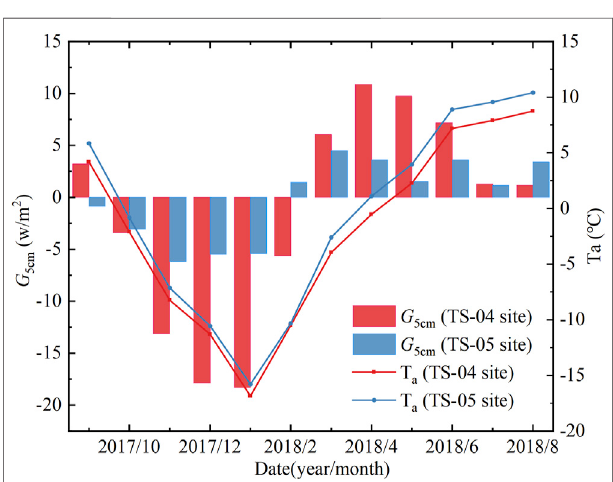
FIGURE3| Monthlymeanchangesofairtemperature (Ta) and5 cmsoil heat fl ux (G 5cm ) at TS-04 and TS-05 sites.